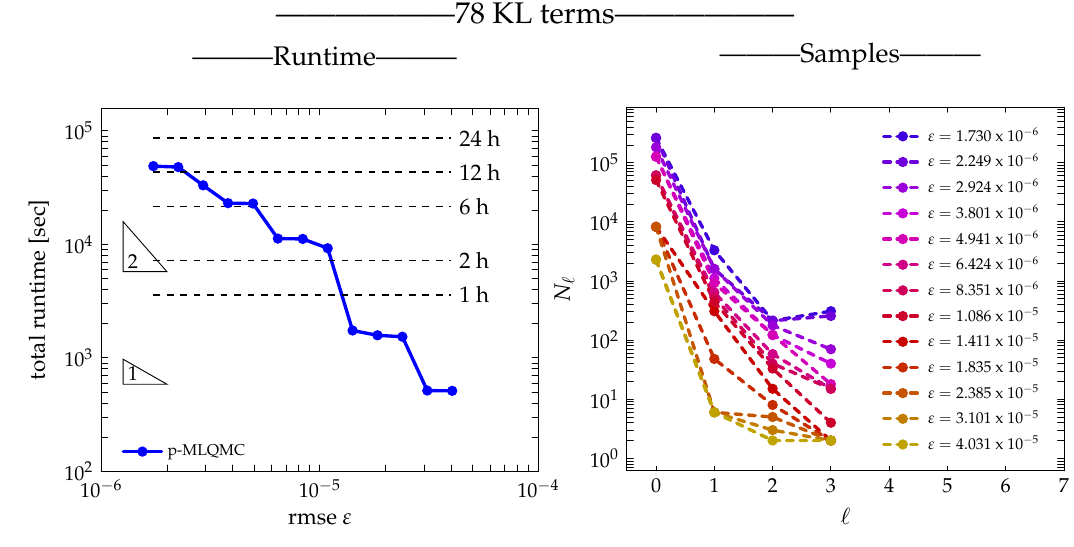
Figure 20. Runtime and sample sizes for a moderate stochastic dimension for model problem 1.